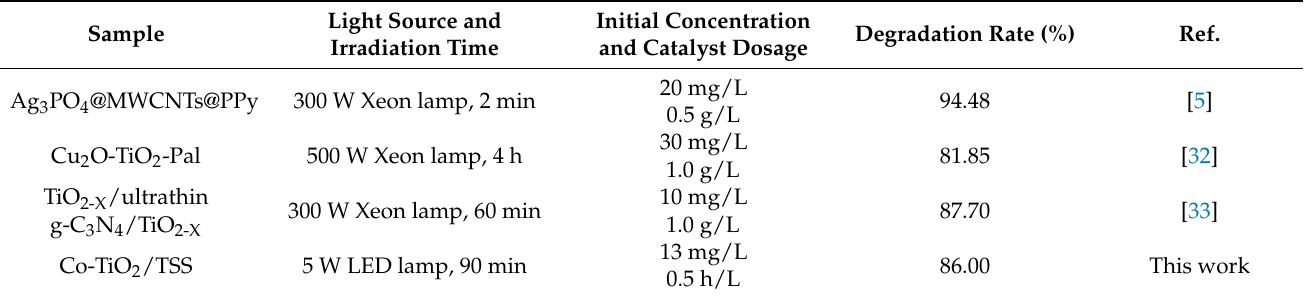
Table 1. Comparison of photocatalytic activity for removal TCH over different photo catalysts.